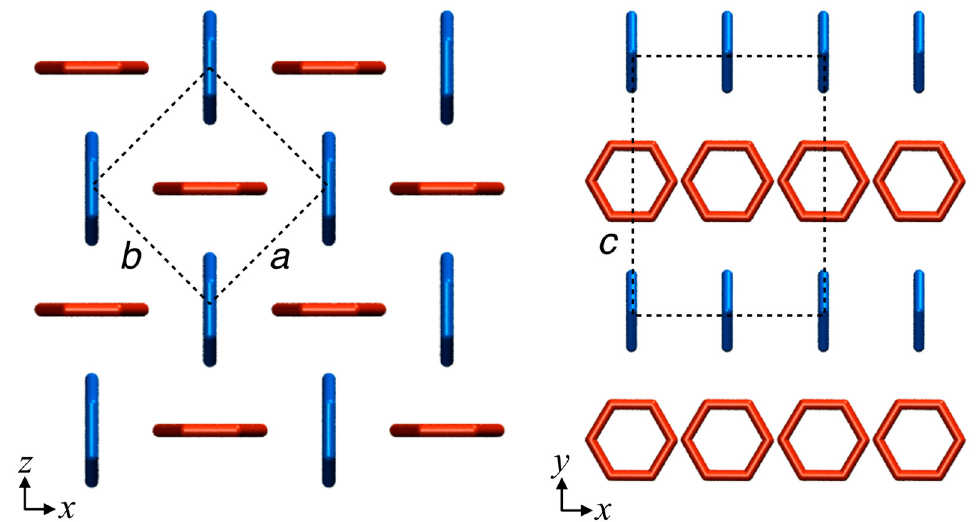
Figure 6. Schematic representation of the metastable phase and its unit cell (dashed black lines). Every other layer along the y axis has the same color code. The x , y , and z for the simulation box and the a , b , and c parameters for the unit cell are shown.